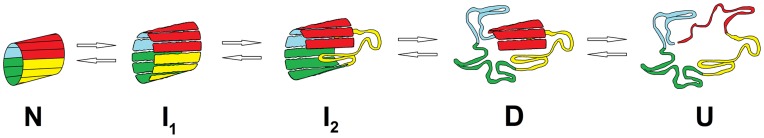
GFP-cycle3 structure formation.Sequence of formation/distortion of secondary structure elements of GFP-cycle3 based on the results of multimutational analysis. N, I1, I2, D, and U are native, two intermediate, denatured and unfolded states of the protein, respectively. At the first stage of unfolding (N→I1) the packing of amino acids on the protein surface is impaired, but the packing of the hydrophobic nucleus as well as the entire packing of the protein chain are not distorted. During the following stage (I1→I2) the structure of β-strands (shown in yellow color) is changed (in the region of amino acids 90–130). After that the protein unfolds almost completely (I2→D), excluding three β-strands in the region of amino acids 10–50 which at “mild” denaturation remain structured in the unfolding state. The last stage (D→U), when the total protein acquires a coil-like conformation, is probable only under the action of strong denaturants.